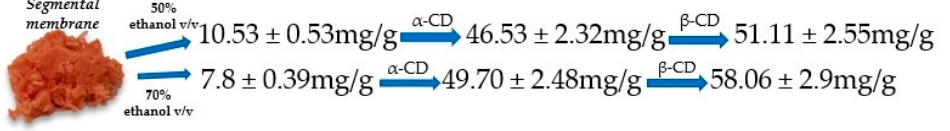
Figure 10. Naringin yield (control sample < α -CD < β -CD, respectively). Results are means ± SD ( n = 3). Table 4. Flavanone concentrations retrieved from samples using CDs.